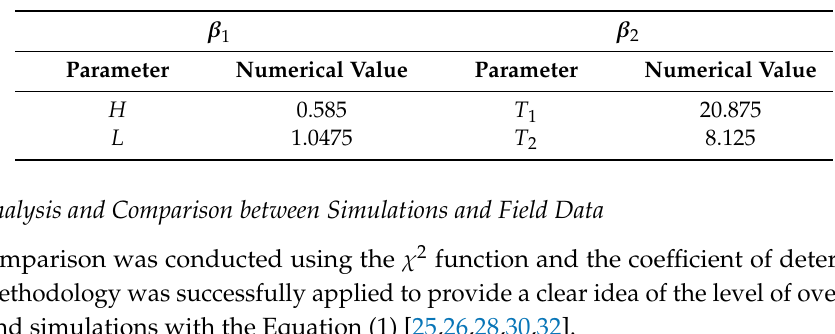
Table 1. Fertility rate function parameters from Asplen et al.